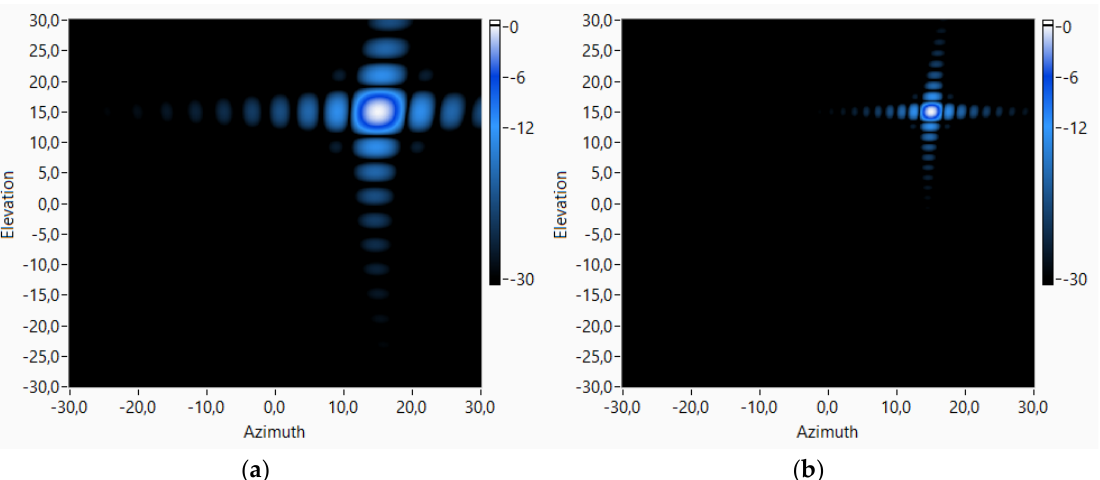
Figure 7. The 80 × 80 array theoretical beam pattern, pointing to (15°, 15°) direction, for working frequencies: ( a ) 4 kHz; and ( b ) 15 kHz.